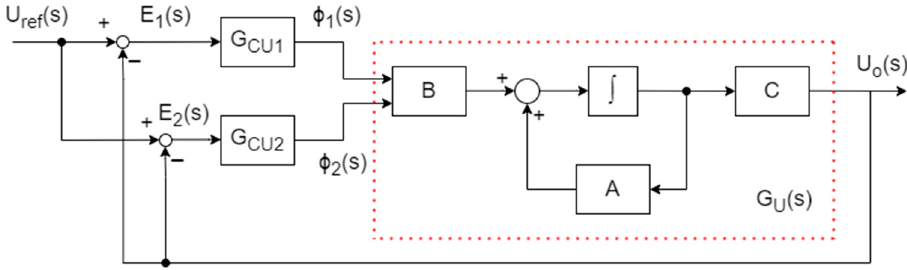
( b ) Figure 7. Bode diagrams for the system using double DD coil structure: ( a ) open-loop Bode diagram; ( b ) closed-loop Bode diagram. The controller was designed with the help of a graphical interface PIDtool , which is included with Matlab. The controller was designed with fast transient response in mind. The static error is corrected using the integral part. An additional requirement was that the response was without overshoot. The equation of the selected PI controller is: ( )